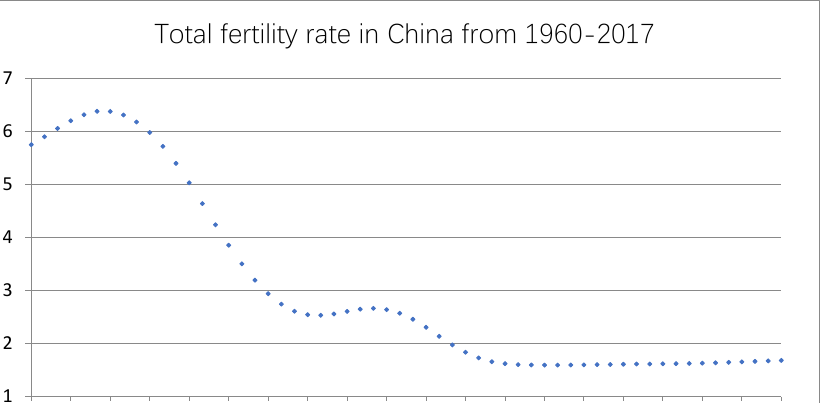
Figure 1. Estimated future age cohorts within China’s population.